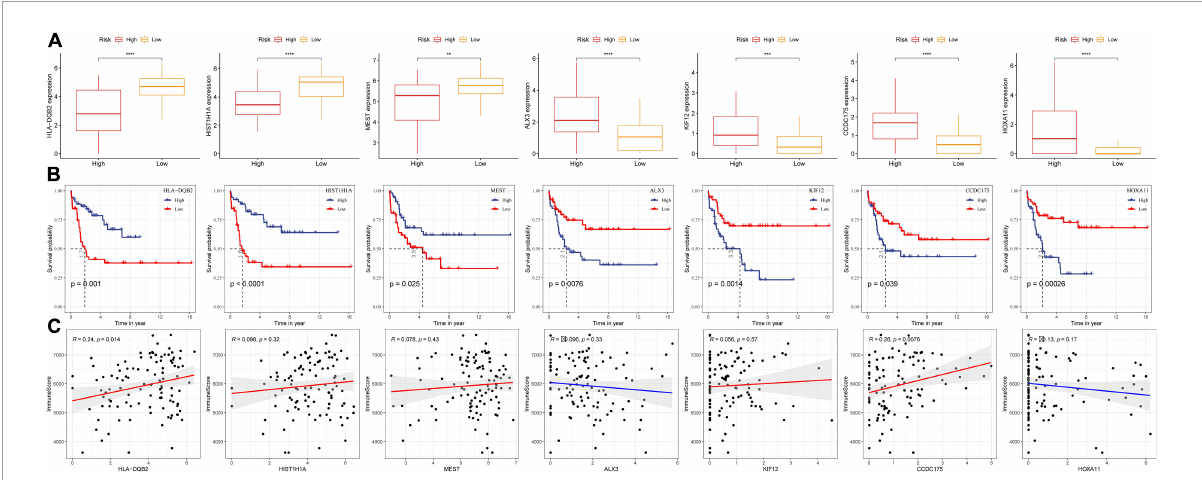
FIGURE7 Correlation analysis between the expression of key DAMPs-related genes in risk models and immune infiltration. (A) The expression of seven key genes in high- and low- risk groups; (B) K–M survival curve of high- and low- gene expression group; (C) Pearson correlation analysis between gene expression and immune score (* P < 0.05; ** P < 0.01; *** P < 0.001; and **** P < 0.0001).